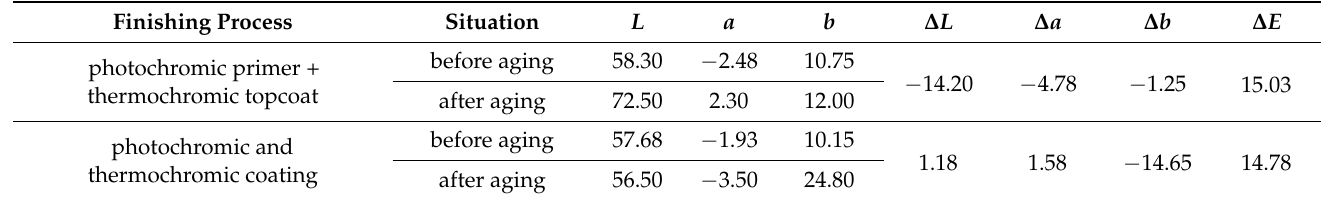
Table 9. The chromatic difference of the film before and after UV photooxidation aging under different finishing